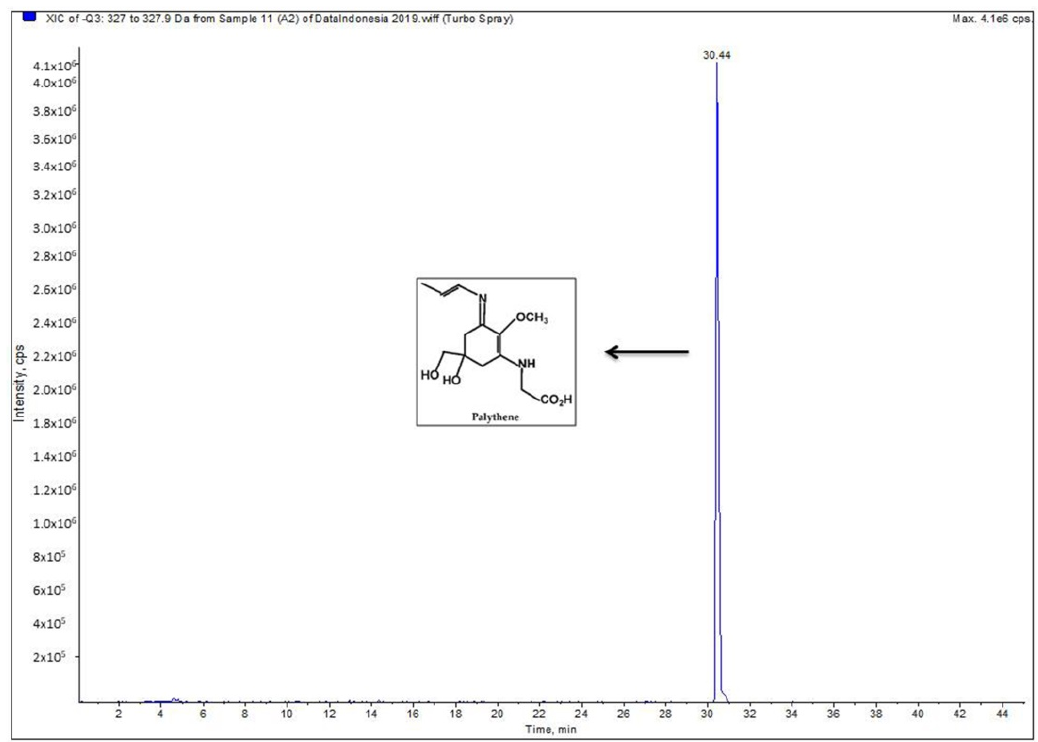
Figure 3. LC / MS analysis of Sargassum cristaefolium ethanol extract Figure 3. LC/MS analysis of Sargassum cristaefolium ethanol extract (0.1%).